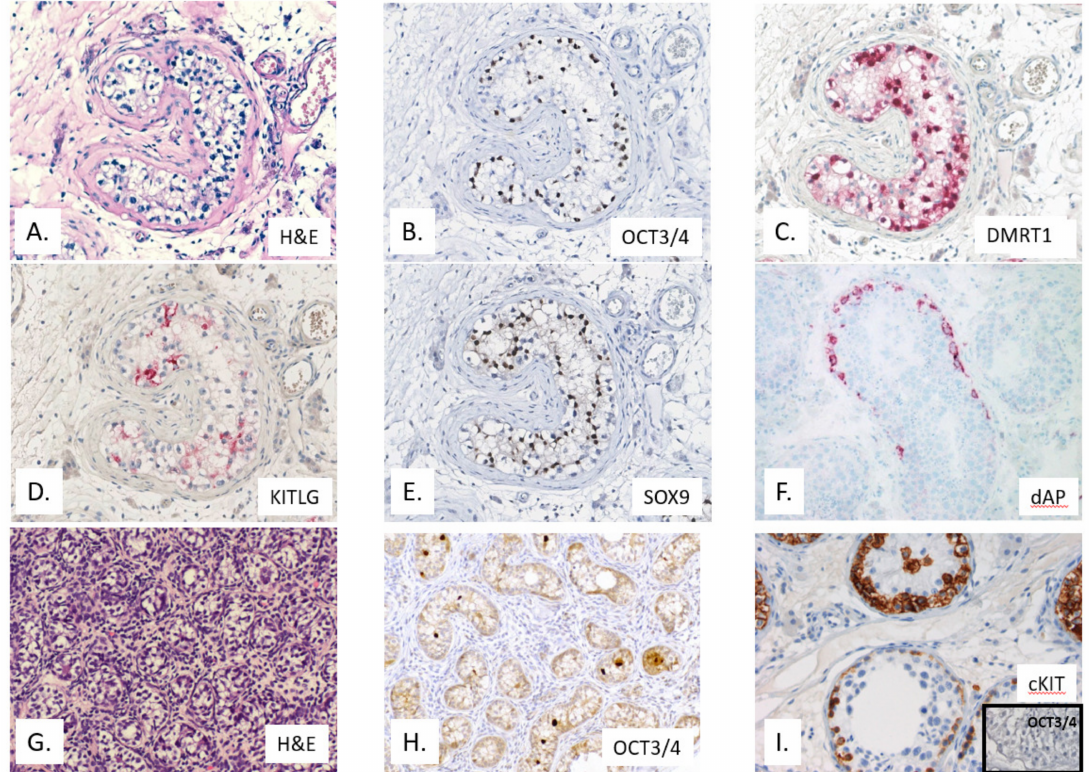
Figure2. Representative examples of germcell neoplasia in situ(GCNIS) (top two rows) (patient 30years of age with a pure seminoma and GCNIS) stained using Hematoxylin & Eosin (H&E) ( A ) and immunohistochemistry for OCT3 / 4 ( B ), TSPY( C ), KITLG ( D ), SOX9 (Sertoli cell marker) ( E ), as well as direct alkaline phosphatase (dAP) ( F ). In addition, the lower row shows a prepubertal testis with delayed maturation (H&E ( G ) and OCT3 / 4 positive ( H )), as well as the “false” positive staining for KIT in normal spermatogonia (being OCT3 / 4 negative) ( I ). Multiplication 200 × , except for G , H 100 ×